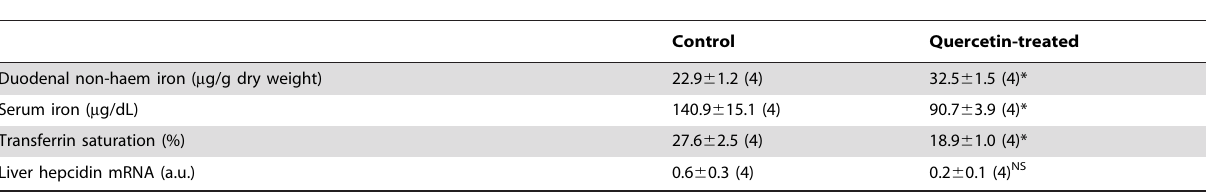
Table 1. Markers of iron status in control and quercetin-treated rats.